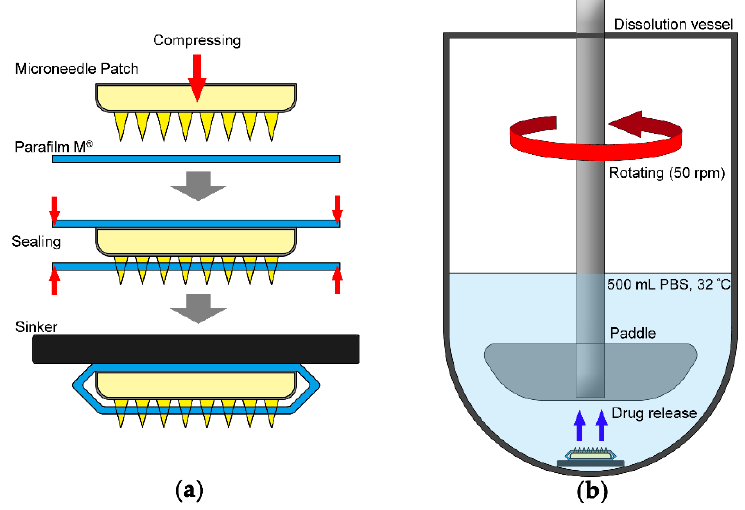
Figure 2 . Schematic diagram of ( a ) DMN patch sample for the drug release and ( b ) test conditions. Samples were collected at the predetermined time, and an equal volume of medium was replaced. The collected samples were diluted appropriately and analyzed at a wave- length of 271 nm using a UV/Vis plate reader (Victor Nivo TM , PerkinElmer Life & Analyt- ical Sciences Ltd., Pontyclun, UK). According to the results of UV spectrum scanning at an interval of 1 nm in the range of 250 to 300 nm, it was confirmed that PVP and trehalose which constitute the DMN matrix did not interfere the analysis of released donepezil at a wavelength of 271 nm (data not shown).